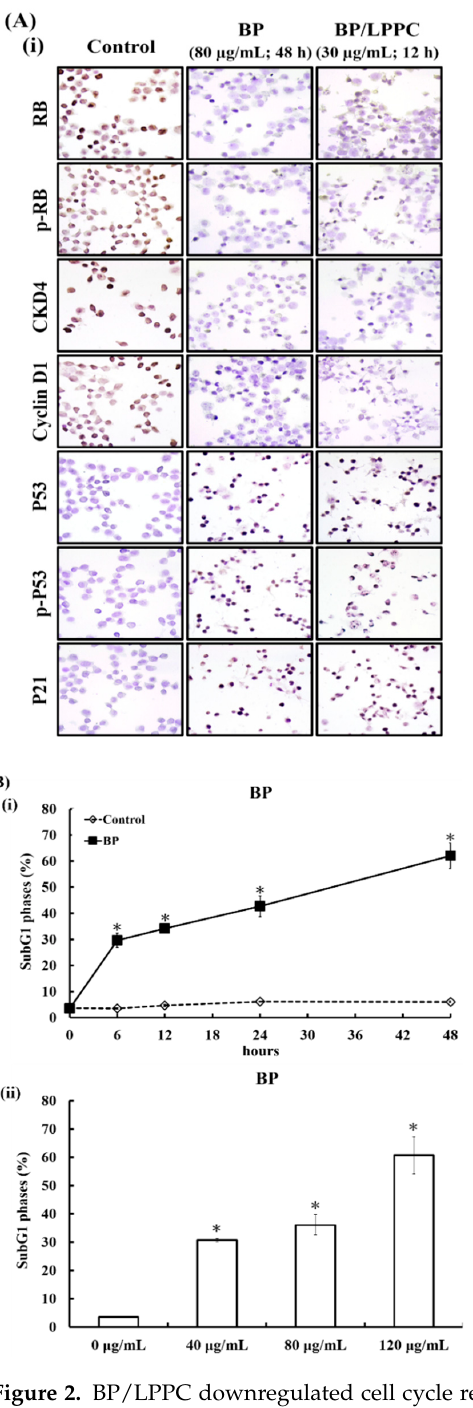
Figure 2. BP/LPPC downregulated cell cycle related protein expression and increased percentage of SubG1 on melanoma cells. ( A ) Cells were treated with BP (80 µg/mL for 6–12 h) and BP/LPPC (60 µg/mL for 24–48 h) and detected protein expression of RB, p-RB, CDK4, Cyclin D1, P53, p-P53 and P21 using immunocytochemistry staining. # p < 0.05 versus control with significant decrease. * p < 0.05 versus control with significant increase. Cells were treated with ( B ) BP and ( C ) BP/LPPC with time course and dosage, and analyzed percentage of subG 1 phase using flow cytometry analysis with propidium iodide staining. Data represents the mean ± SD; * p < 0.05 versus control.